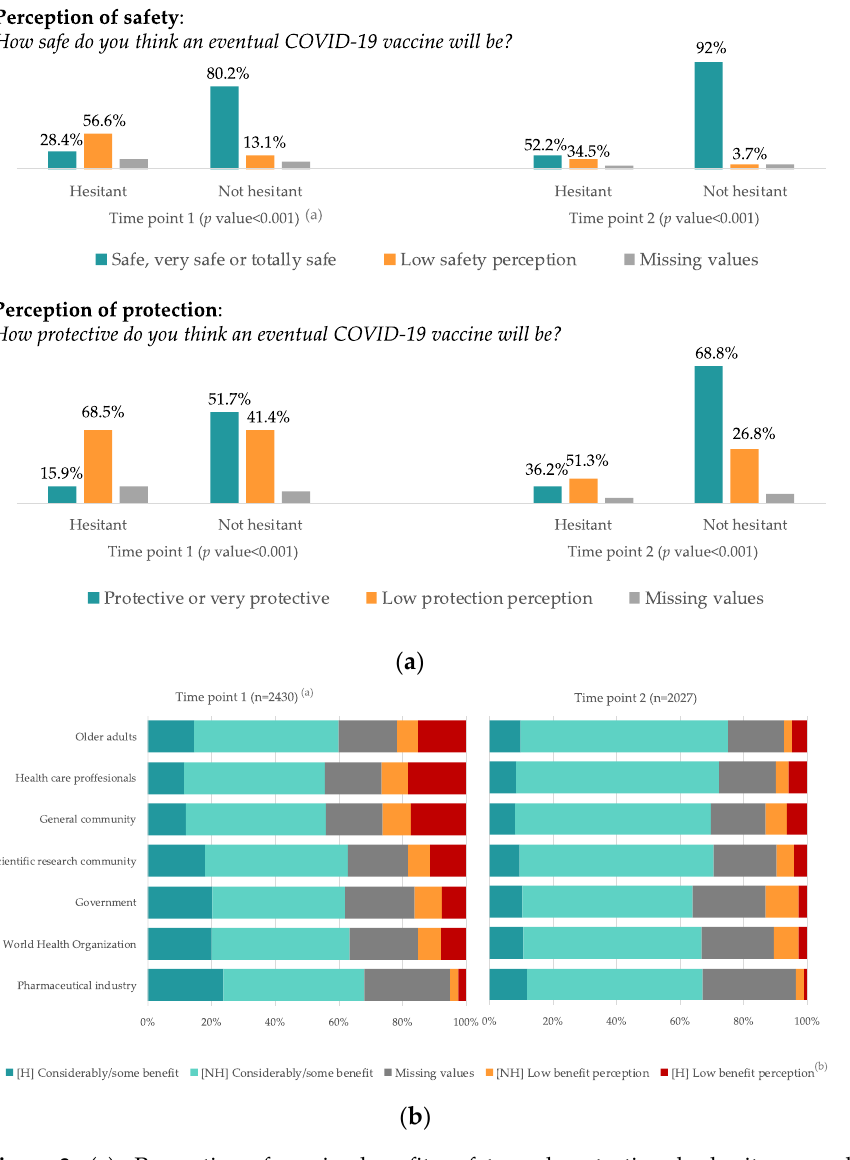
Figure 3. ( a ). Perception of vaccine benefit: safety and protection, by hesitancy and time point. COVID-19 Vaccine Hesitancy Study. Barcelona. 2020–2021 .(a) Chi square test between hesitant and non-hesitant nurses does not include missing values. Chi square test between submissions were <0.001 for both variables. Bar graphs present the absolute frequency between each group studied (safety or protection) in both submissions, while the percentage frequency presents the risk perception separately in each group of nurses, according to VH or non-VH. ( b ) Perception of vaccine benefit: benefit in specific populations, by hesitancy and time point. COVID-19 Vaccine Hesitancy Study. Barcelona. 2020–2021. ( a ) Chi square test between hesitant and non-hesitant groups was <0.001 in all comparisons and does not include missing values. Chi square test between submissions was <0.001 in all variables, except government ( p = 0.009) and the pharmaceutical industry ( p = 0.141 ).(b) H: Hesitant nurses, NH: Non- hesitant nurses. Missing values includes “Doesn’t know/No answer”.